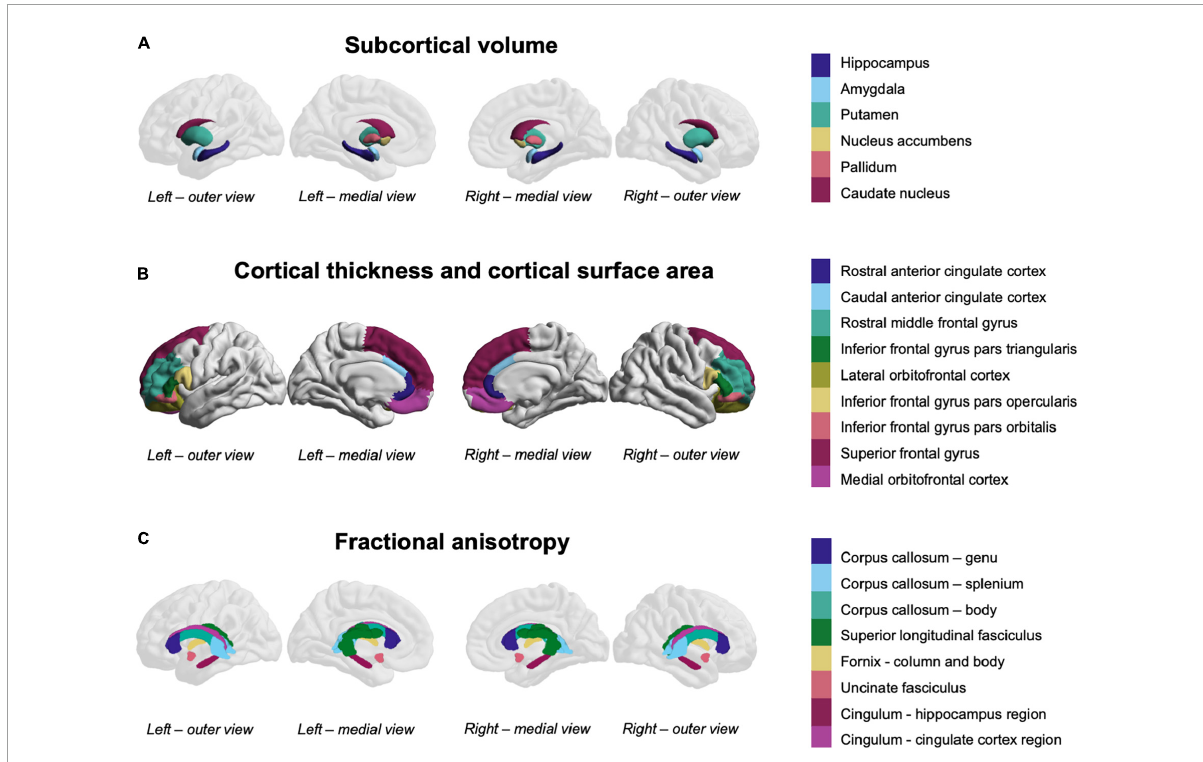
FIGURE1 Fronto-limbic and fronto-striatal regions-of-interest. (A) Subcortical volume was measured in the colored subcortical structures (overlaid on a reference brain for orientation). (B) Cortical thickness and cortical surface area were measured in the colored cortical structures. (C) Fractional anisotropy was measured in the colored white matter structures (overlaid on a reference brain for